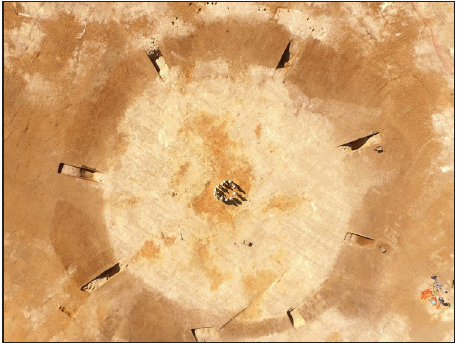
Figure 5: Late Iron Age/Early Roman crema- tion burial site, Basildon (Photo: